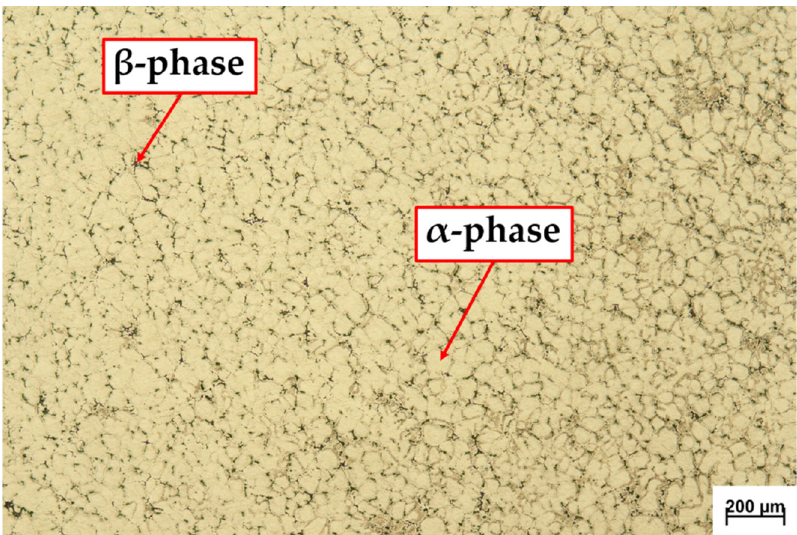
Figure 1. Microstructure of the base SSM 5083 aluminum alloys.